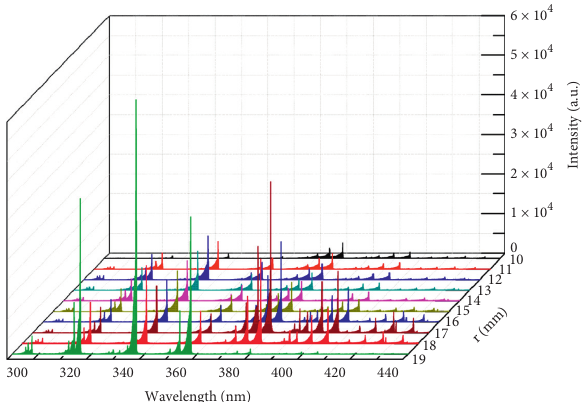
Figure 10: The spectral distribution trend of ten collection points in the radial direction, when the input voltage was 130V and the air flow was 200L/min.